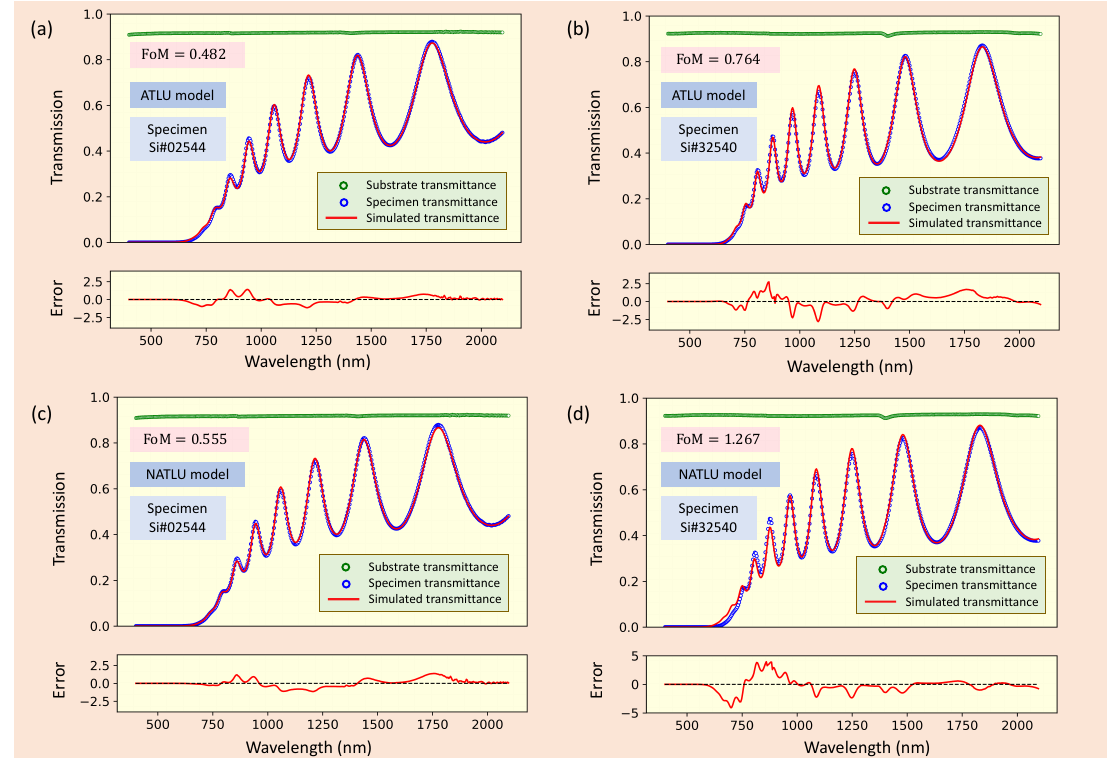
Figure 3. Two examples of the typical normal-incidence transmission spectrum of an approximately 1.1- µ m-thick amorphous Si thin film that have been sputtered on a transparent glass substrate, held at a temperature of ( a ) 25 °C and ( b ) 325 °C, during the sputtering deposition process. Furthermore, the NATLU- and ATLU-generated transmission spectra of the previous two a -Si specimens, are also displayed. The relative difference between the experimental and simulated transmittance curves is also displayed in this figure for the two representative a -Si